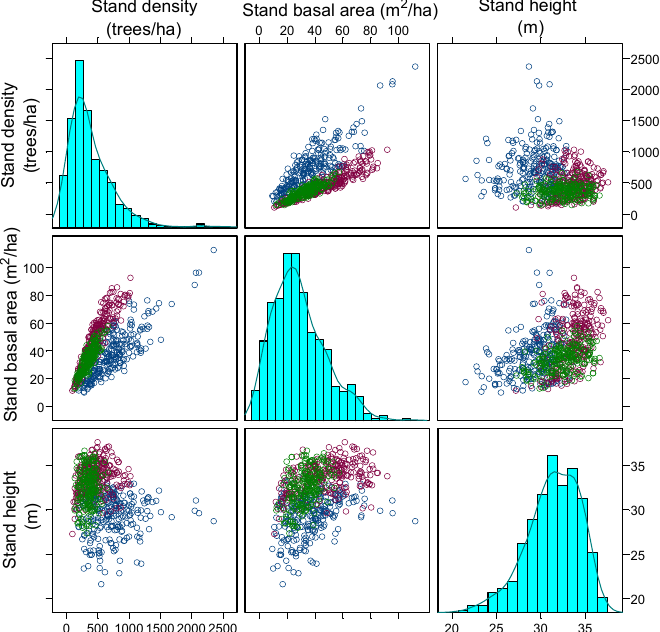
Figure 6. Scatterplot matrix of stand-level attributes calculated for individual grid cells for the T0 (blue), T1 (brown), and T2 (green) plantations.